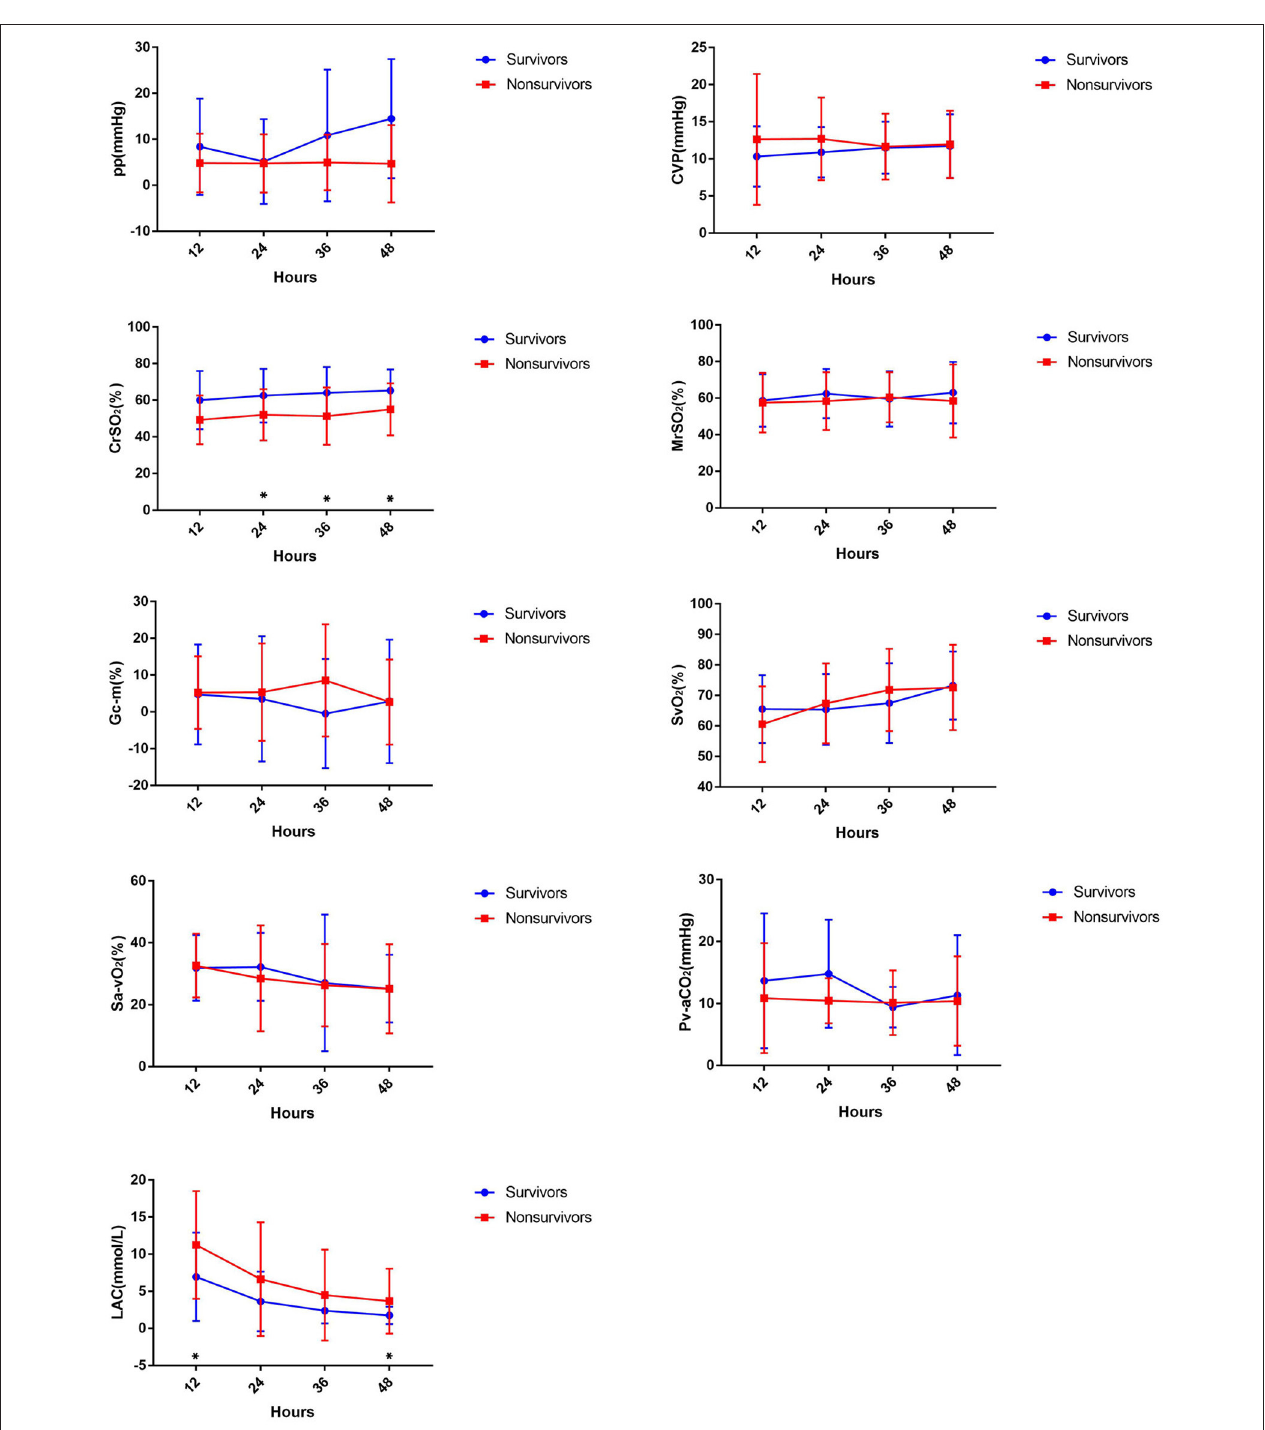
FIGURE 1 | Comparing hemodynamic parameters in the first 48h between survivors and non-survivors during ECMO.